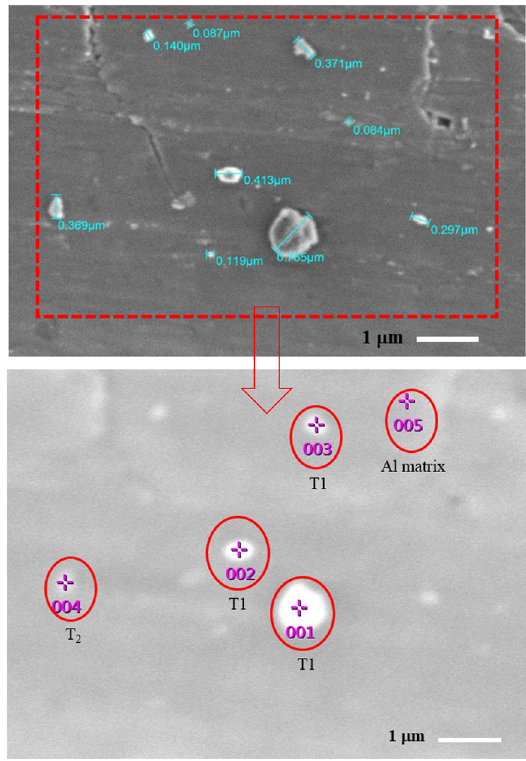
Figure 1. SEM observation of the 2524-T3 aluminium alloy before the electrochemical